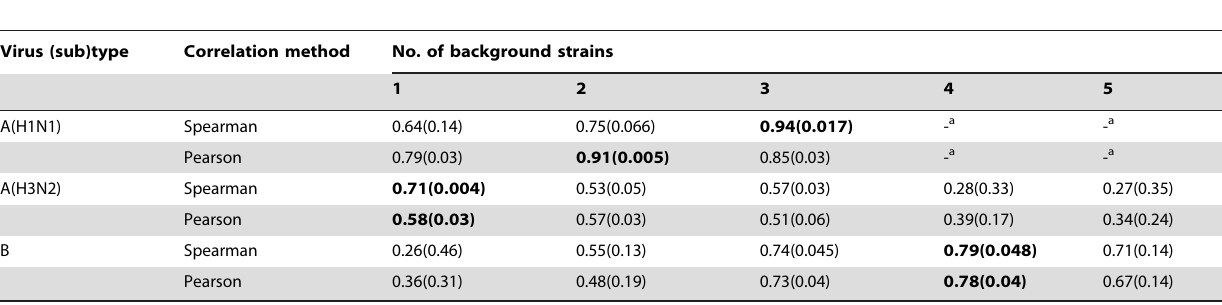
Table 2. The Spearman and Pearson Correlation Coefficients between the excess all-cause mortalities and the integrated antigenic distances relative to the previous 1–5 antigenic strains as background